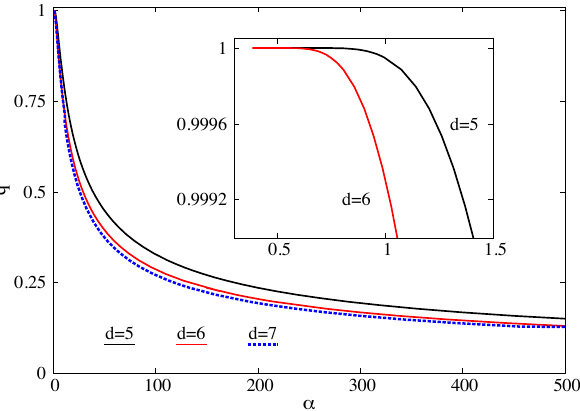
Figure 1 . Existence lines for the d = 5 ; 6 ; 7 RN BH in a (cid:11) vs. q diagram. The inset zooms around the minimal value of (cid:11) .